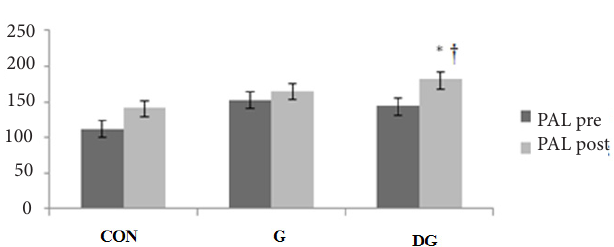
Figure 3. Physical activity levels (PAL) pre- and post-intervention in the group that did not complete the diary or receive guidance on healthy lifestyle (CON); group that did not use the diary but received guidance on healthy lifestyles (G); and the group that both used the diary and received guidance on healthy lifestyles (DG). *p < 0.05 related to pre-intervention in the same group. †p < 0.05 related to post-intervention in the CON group.